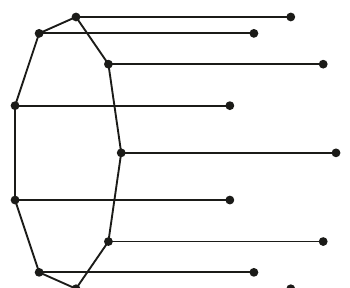
Figure 7: The graph generated by adding an edge with a vertex to every vertex of 𝐶 9 .